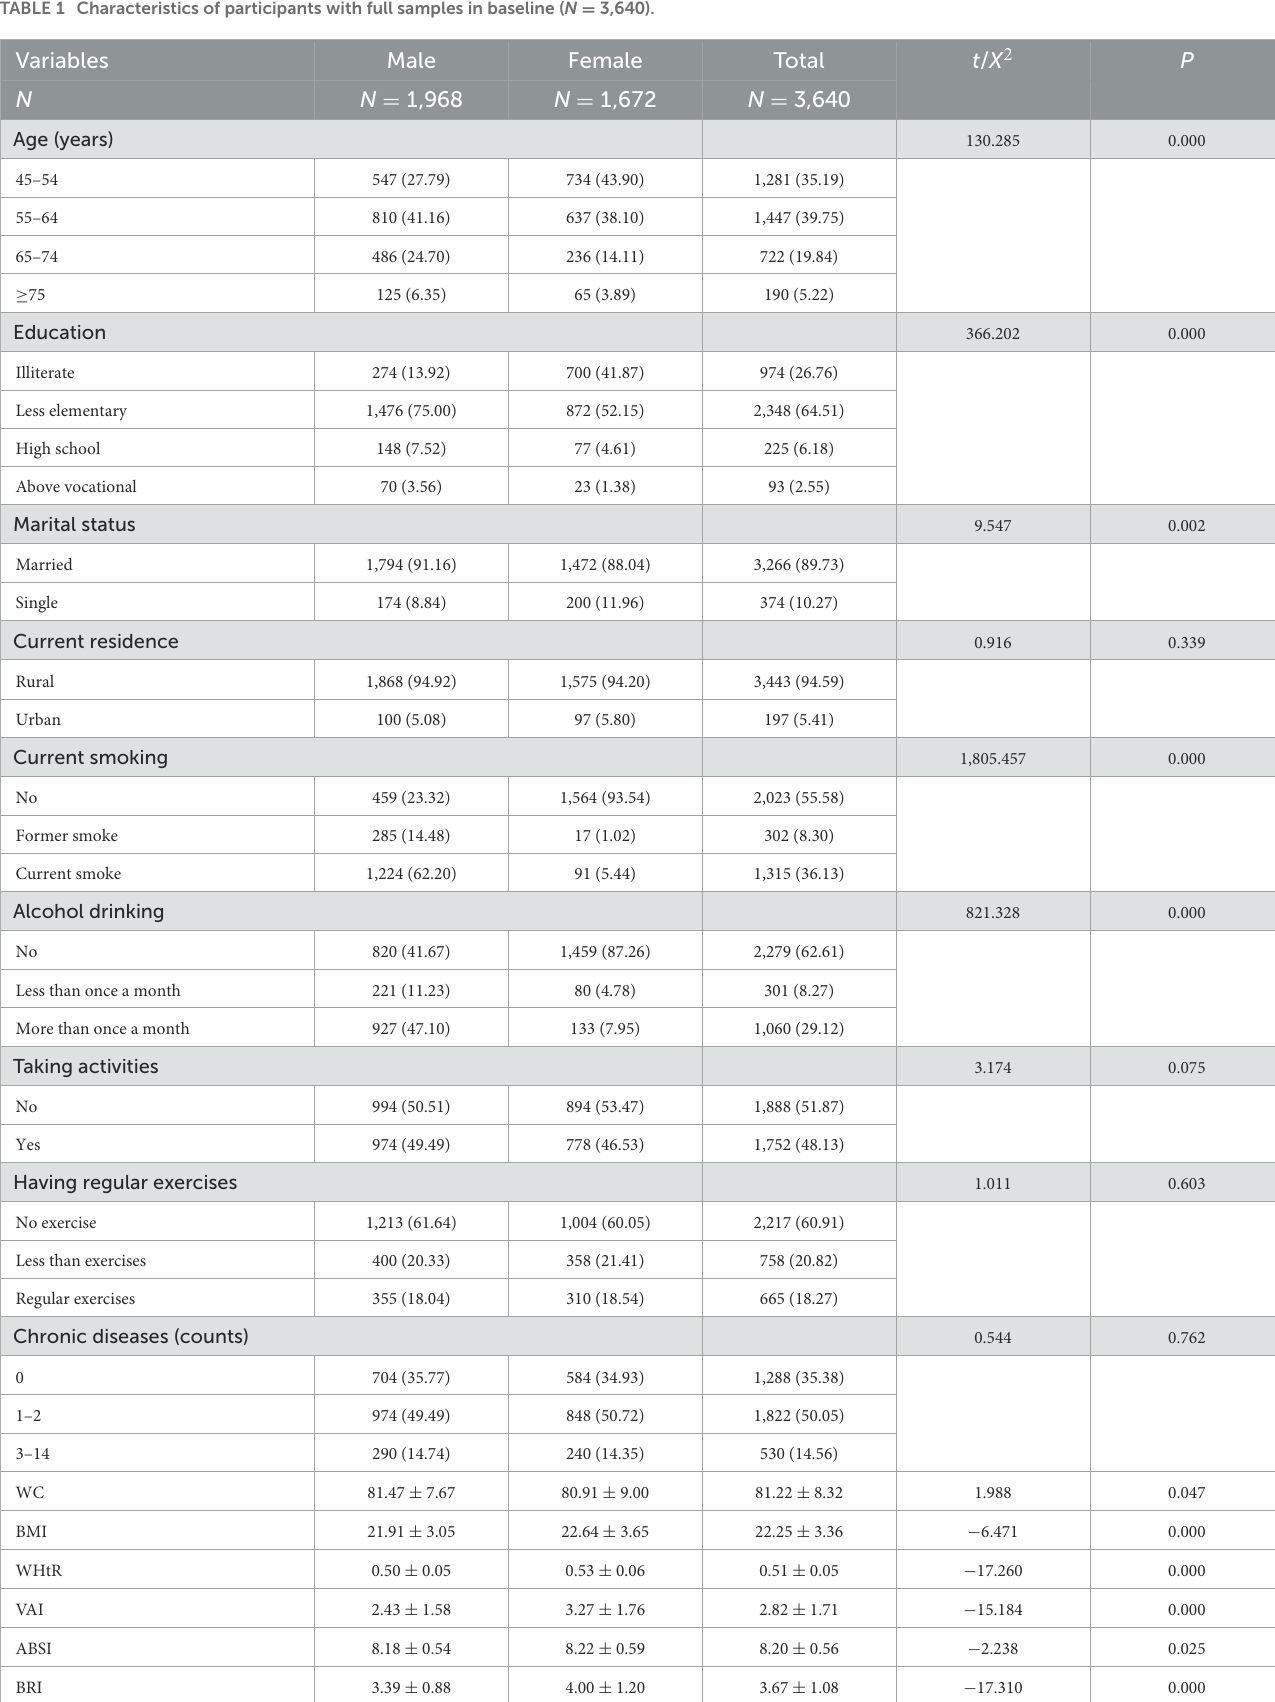
TABLE 1 Characteristics of participants with full samples in baseline ( N =